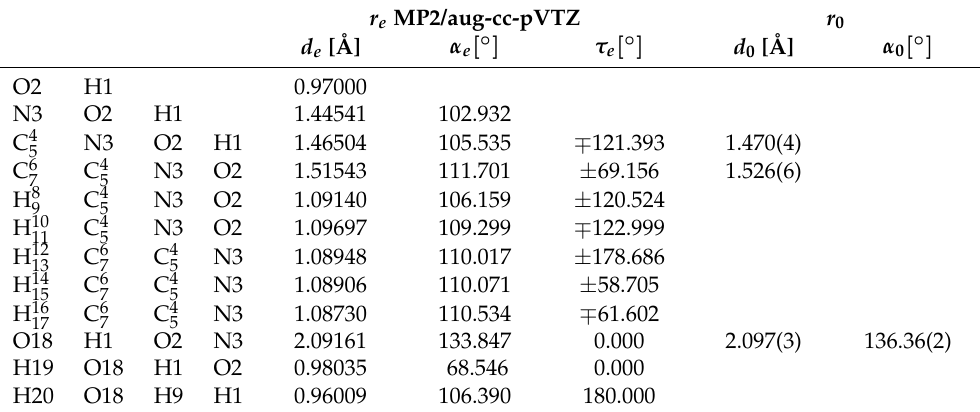
Table 4. Theoretical structure ( r e ) and derived r 0 parameters of DEHA-W in the symmetric ( C s )